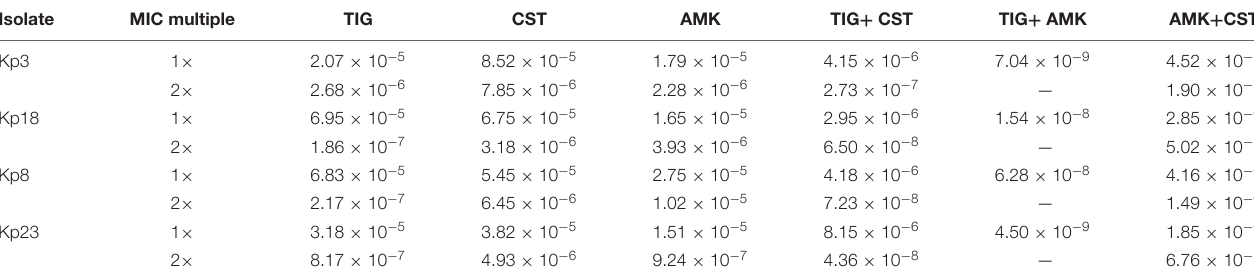
TABLE 2 | Mutational frequencies of drug-isolate combinations at 1 MIC and 2 MIC multiple.